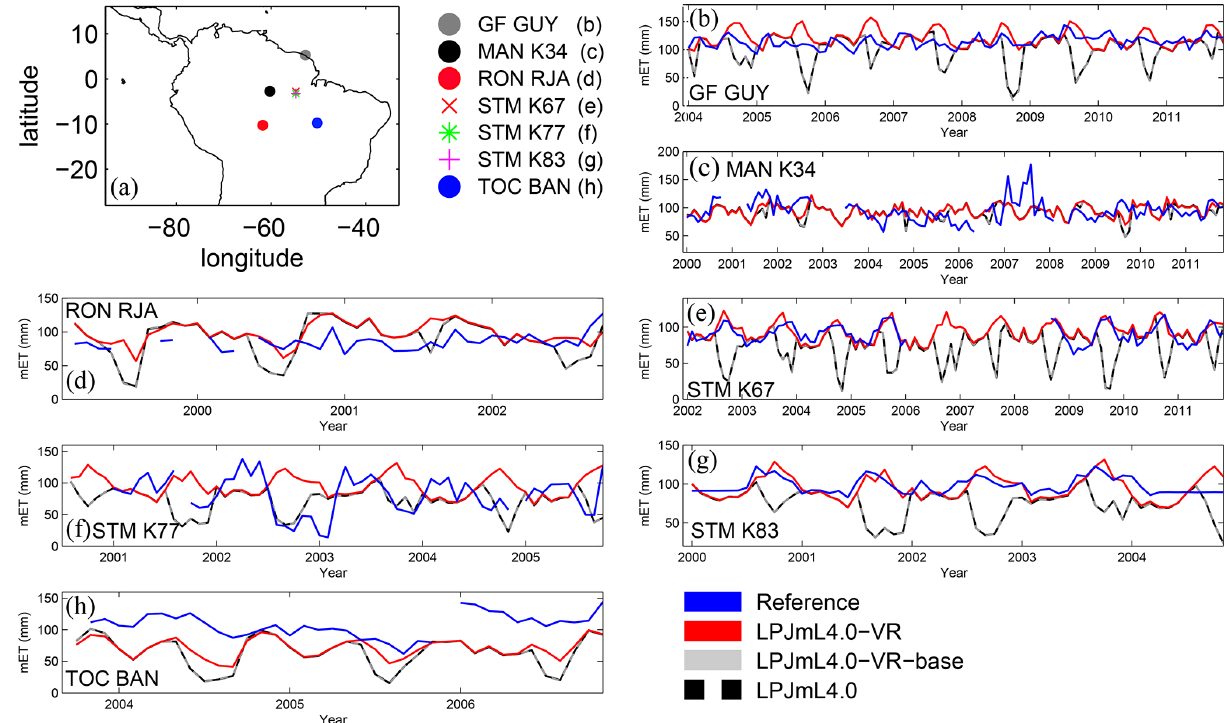
Figure B6. Comparisons of monthly ET between different FLUXNET sites (Reference; see also Sect. 2.5.1) and respective simulation output of the different LPJmL model versions used in this study forced with CRU climate. (a) Geographical location of different FLUXNET sites (see also Table A3). For statistical measures of the individual comparison, see Table B1.